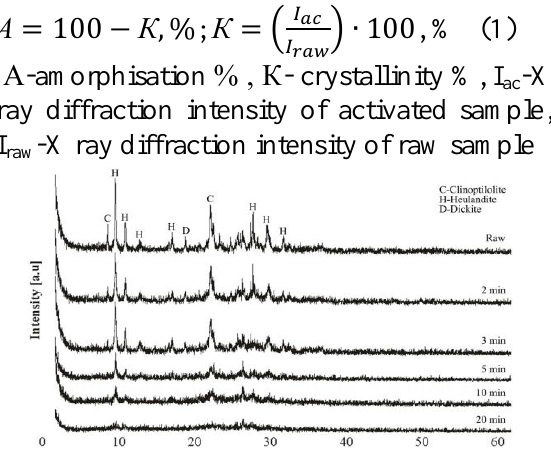
Fig.1 XRD patterns of the raw and activated Tsagaan tsav zeolite.